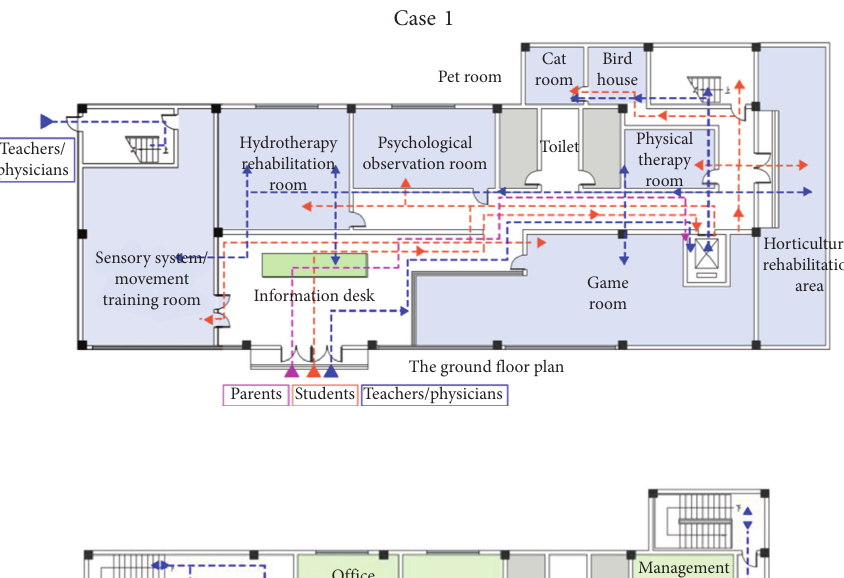
Table 2: Layout and functional